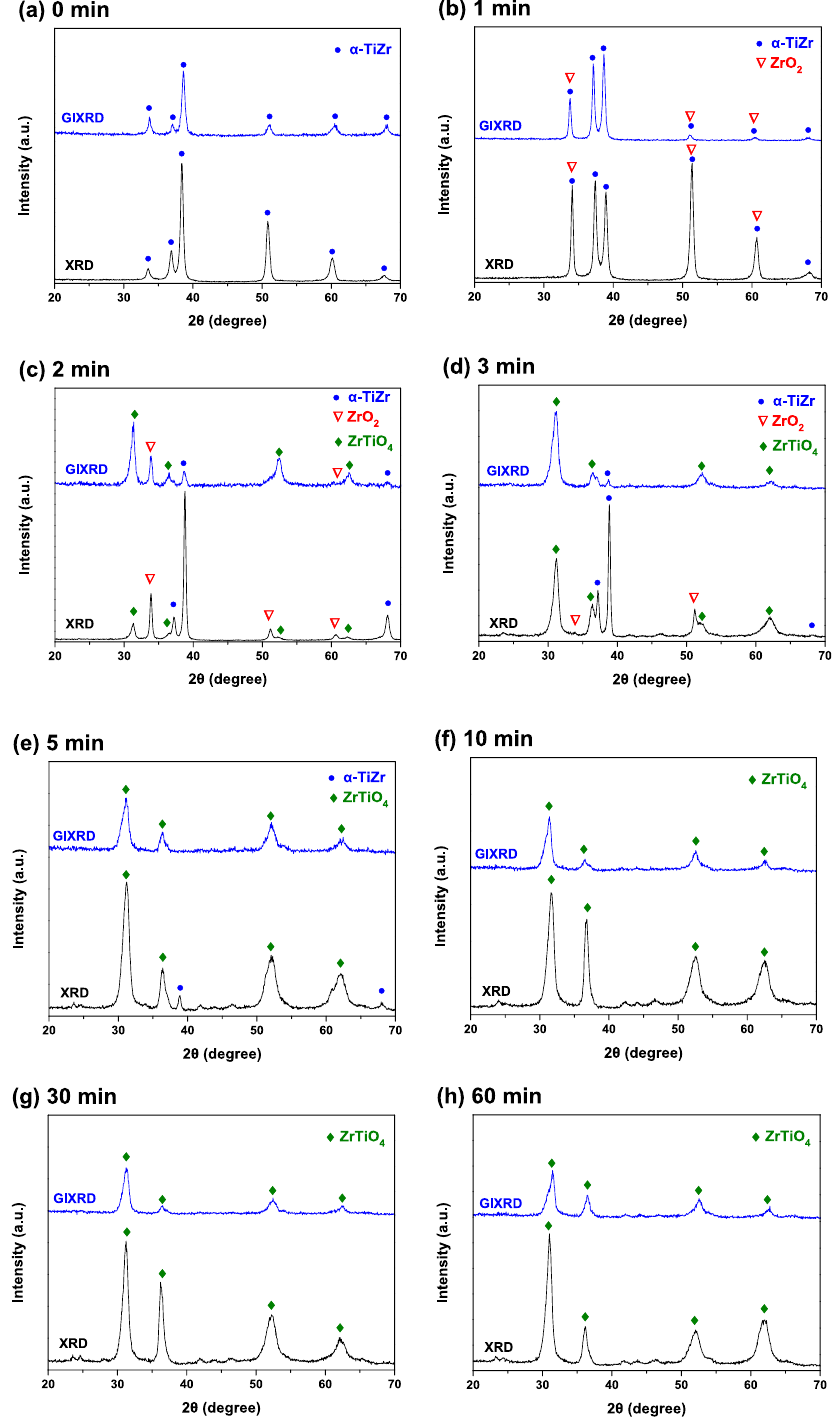
Figure 1. XRD and GIXRD patterns of the TiZr alloy specimens heat-treated at 600 °C for ( a ) 0 min, ( b ) 1 min, ( c ) 2 min, ( d ) 3 min, ( e ) 5 min, ( f ) 10 min, ( g ) 30 min, and ( h ) 60